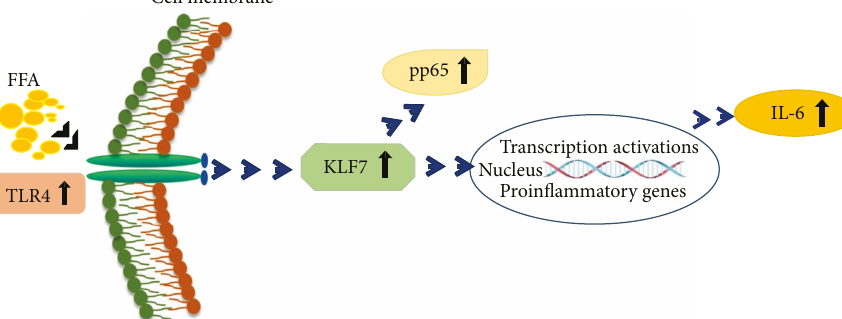
Figure 7: Schematic diagram: KLF7 plays an important role in the activation of FFA/TLR4/IL-6 in fl ammatory signaling pathways in